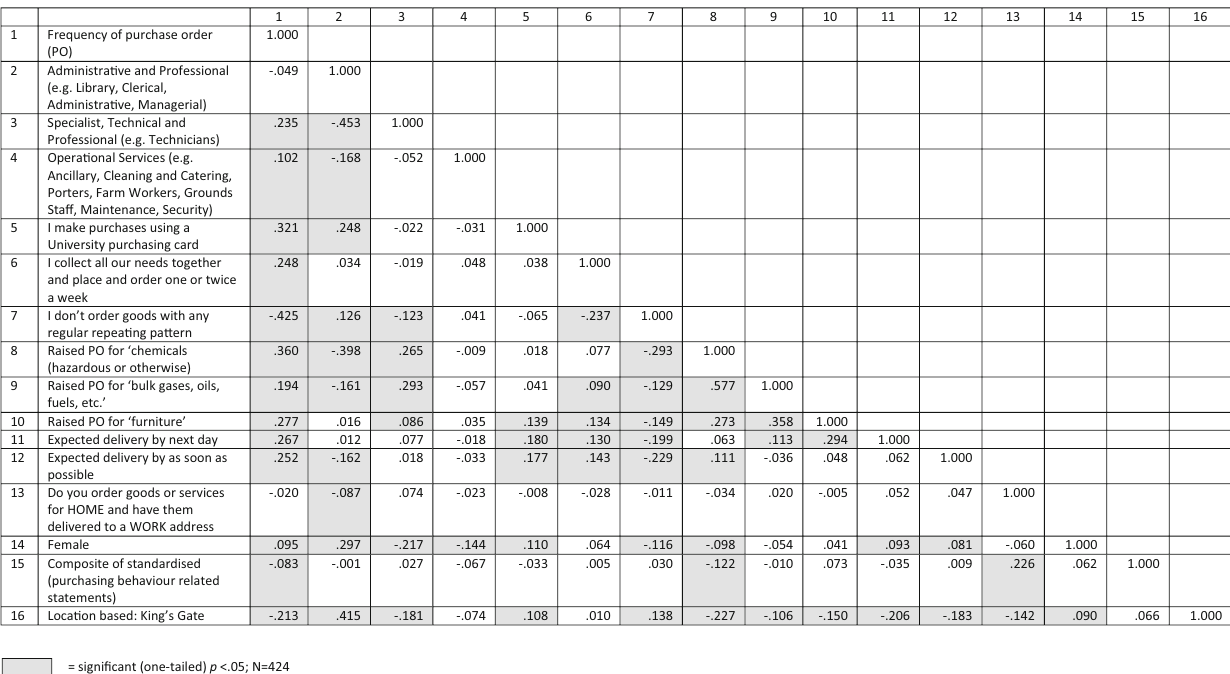
Pearson correlation coefficient of all variables with small to medium relationship effect included in the regression.